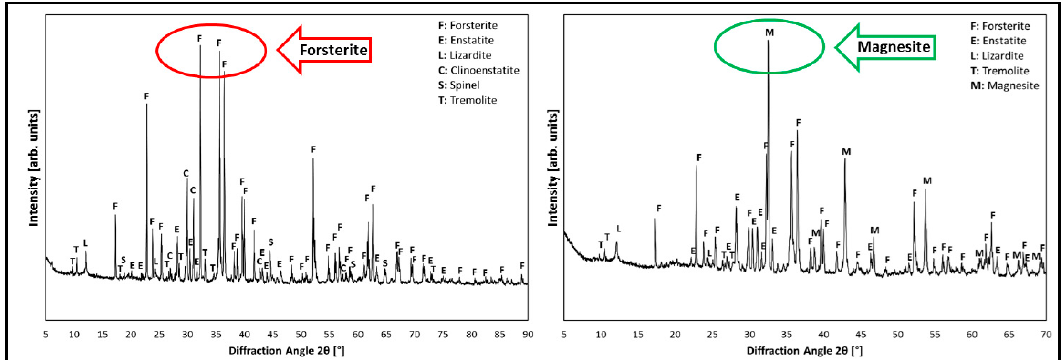
Figure 4. X-ray diffraction (XRD) analysis of Italian olivine sample; initial state ( left ) and carbonation product ( right ) [1].